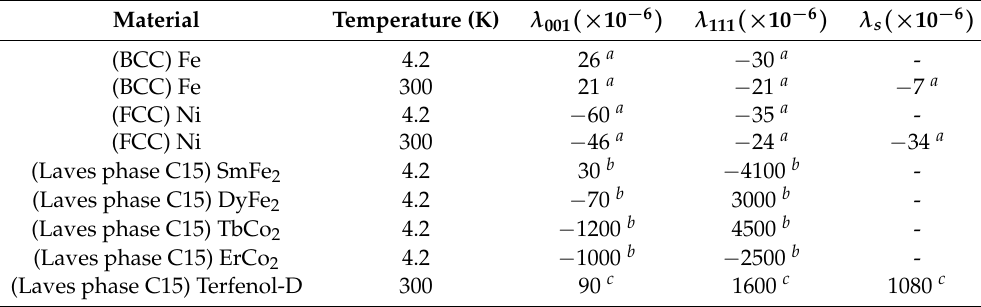
Table 1. Magnetostrictive coefficients of some cubic crystals.